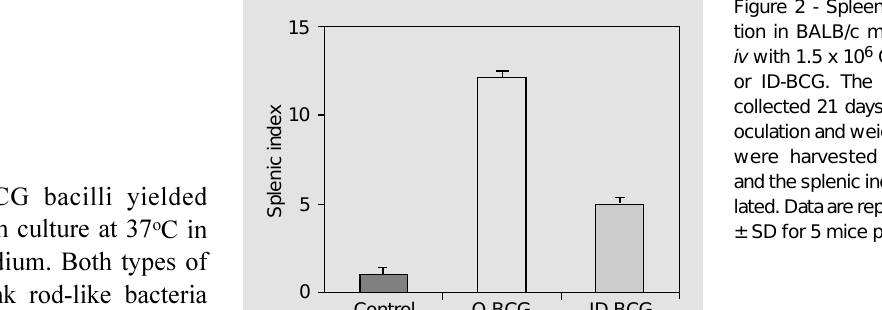
Figure 2 - Spleen cell prolifera- tion in BALB/c mice inoculated iv with 1.5 x 10 6 CFU of O-BCG or ID-BCG. The spleens were collected 21 days after BCG in- oculation and weighed, the cells were harvested and counted and the splenic index was calcu- lated. Data are reported as mean ± SD for 5 mice per group.